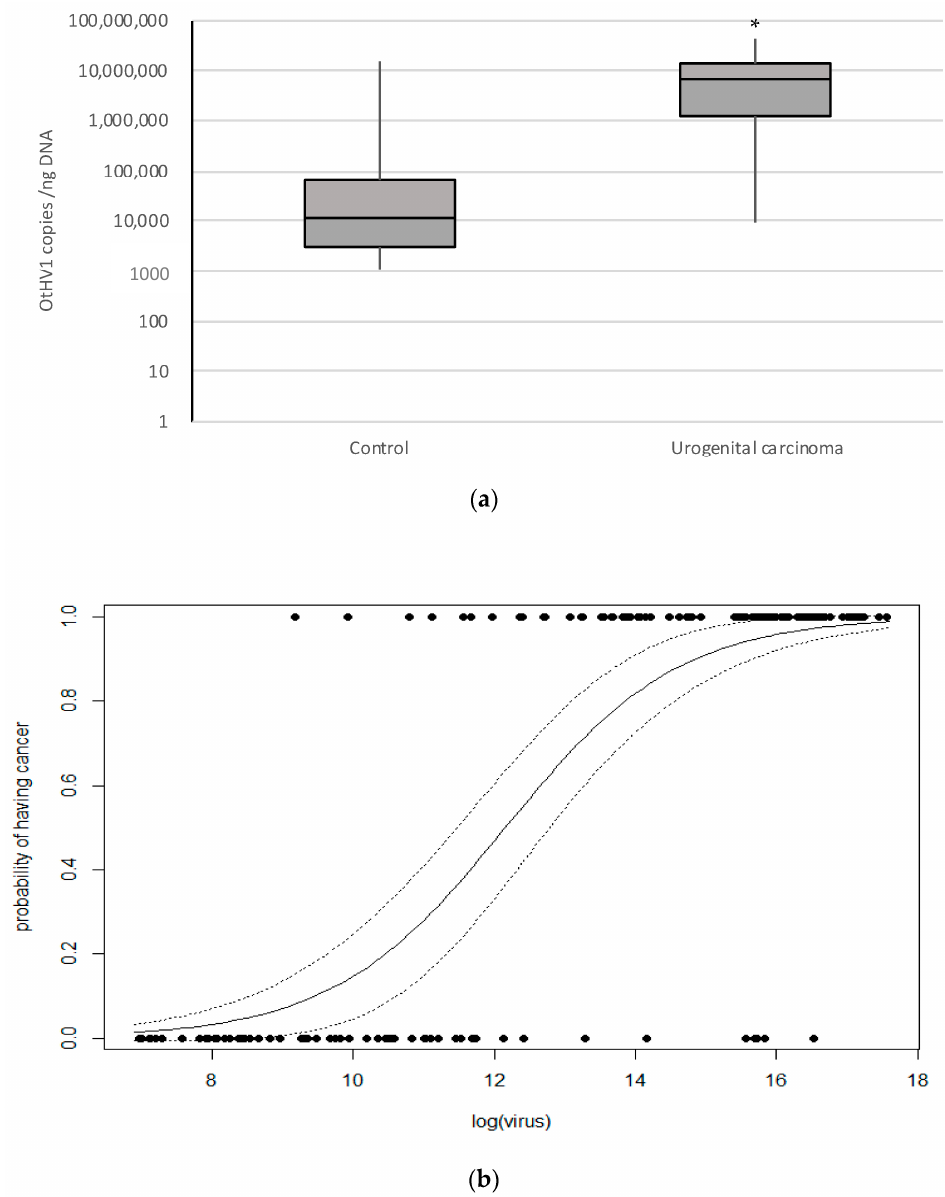
Figure 1. The above graphs show OtHV1 qPCR results from California sea lion cancer and control cases that were qPCR positive for OtHV1. ( a ) Box plot representing OtHV1 viral copies per nanogram of DNA detected (copies/ng DNA) determined by OtHV1 qPCR, including all OtHV1 positive histologically normal cervix (control; n = 59) and urogenital carcinoma (cancer; n = 95) cases. * = significantly different ( p < 0.0001). ( b ) Binomial general linear model of the probability of having cancer based on the abundance of OtHV1 (log of number of viral copies detected per nanogram of DNA in the reaction) quantified with OtHV1-specific qPCR. Non-cancer cases are on 0.0 and cancer case are on the 1.0